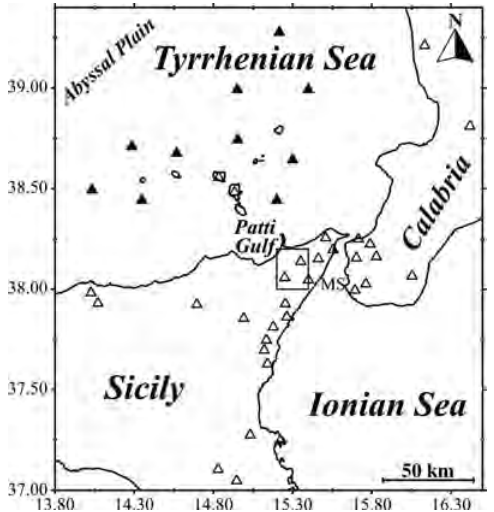
Fig. 2. Map of on-shore (empty triangles) and off- shore stations (full triangles) used in the present study. The on-shore stations belong to the local and national networks of INGV for the Mt. Etna and Ital- ian territory surveillance. The square shows the north-eastern Sicily area of the March 2001